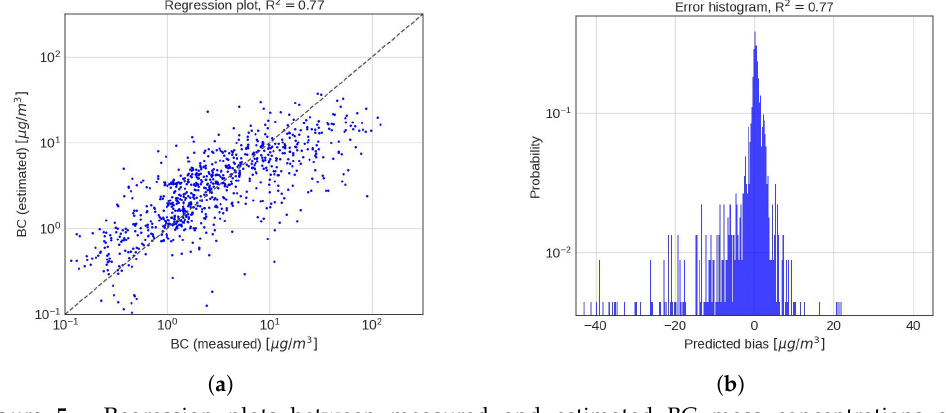
Figure 5. Regression plots between measured and estimated BC mass concentrations and error histogram between measured and estimated BC mass concentrations. ( a ) Regression plot. ( b ) Error